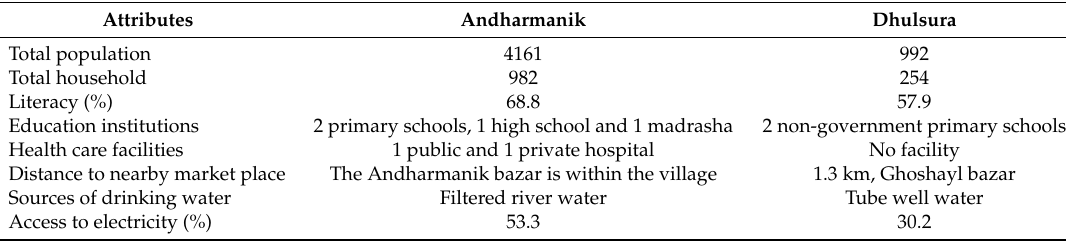
Table 1. Profile of the study